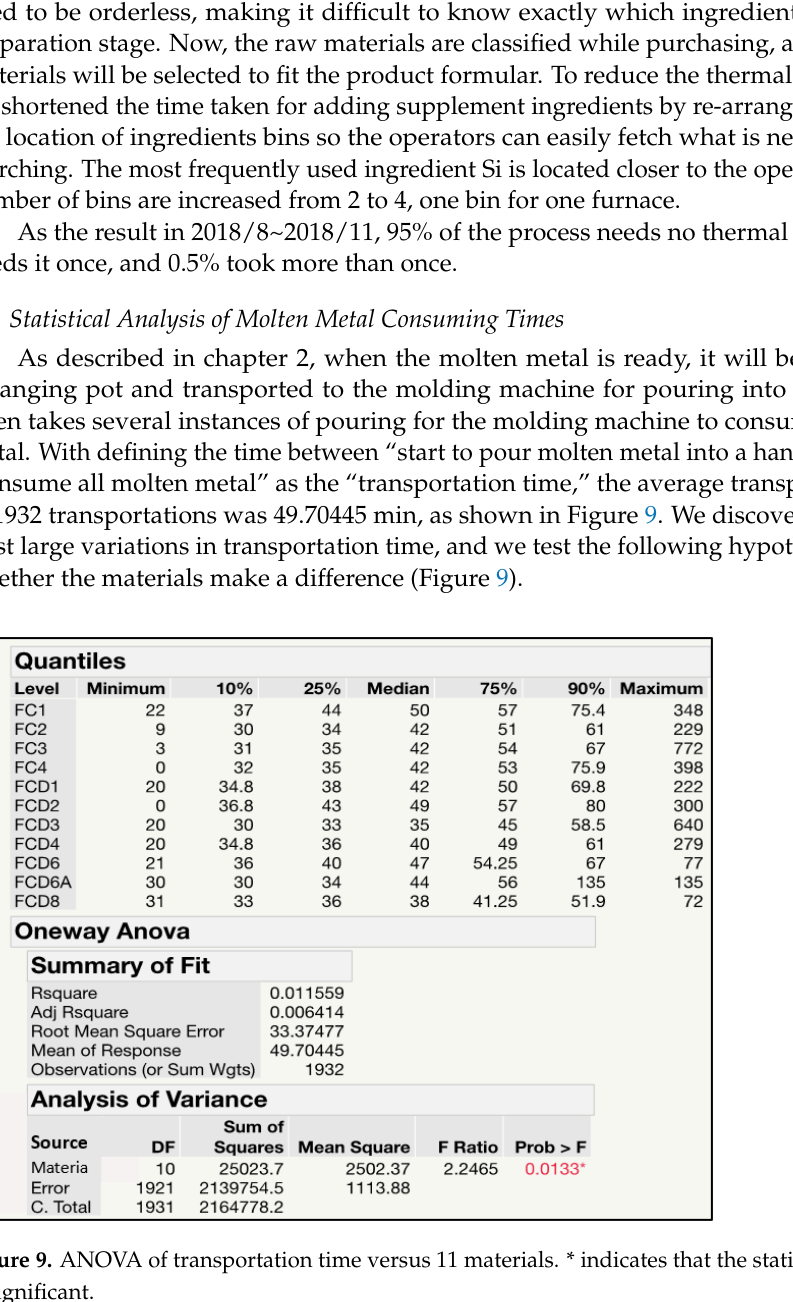
Table 4 . LSD analysis of transportation time versus 11 materials .